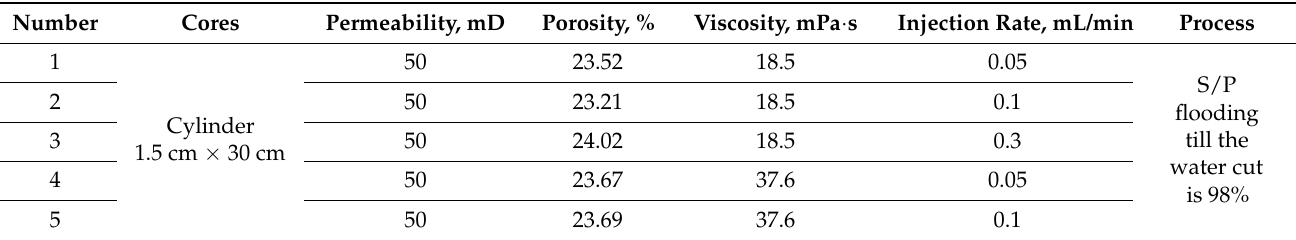
Table 2. The classification criteria of the four swept regions.